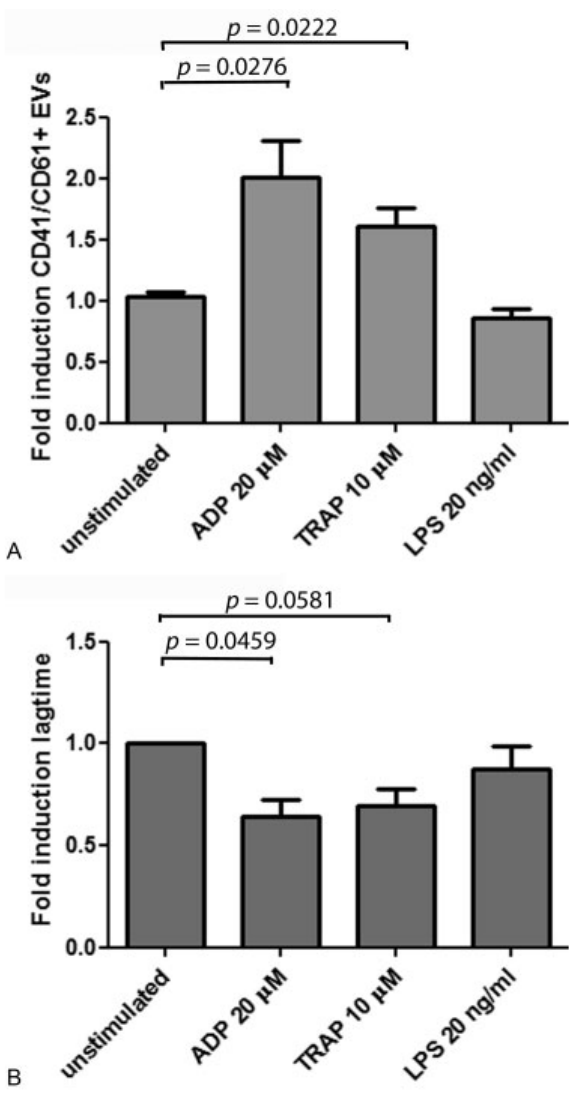
Fig. 3 Platelet-derived EVs in plasma samples measured by SP-PLA and a thrombingenerationassay.Wholebloodwasstimulatedornot with20 μ M ADP, 10 μ M TRAP, or 20 ng/mL LPSin 37°C for 3 hours to generate EVs. ( A ) CD41/CD61 þ EVs were detected with SP-PLA and the levels are shown as fold induction from the meanvalue of plasmapreparedfrom unstimulated wholeblood(unstimulated, set to1).Errorbarsrepresent standarderrorof the mean (SEM). Differences between groups were tested with unpaired Student ’ s t -test, and a p -value < 0.05 was considered signi fi cant. ( B ) Thrombin generation was studied in the same samples using calibrated automated thrombogram (CAT). Fold induction of the lag time in plasma from unstimulated whole blood is shown. Error bars represent SEM from threeindividualexperiments.Differencesbetweengroupsweretestedwith a paired, two-tailed Student ’ s t -test. A p -value < 0.05 was considered signi fi